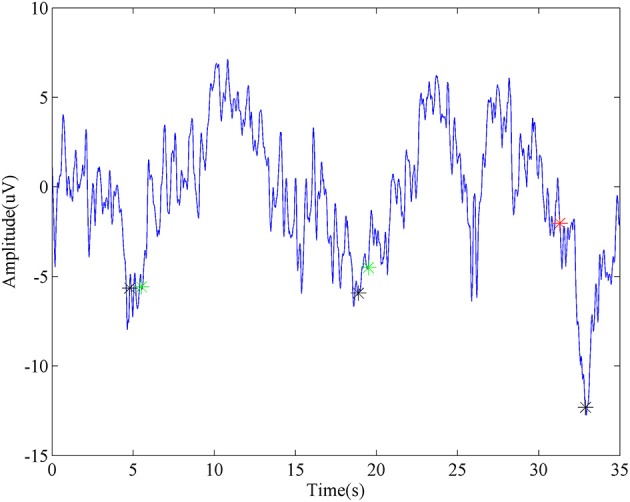
Representative detection of MRCP. The blue line is a segment of virtual Cz from ballistic task. Black stars stand for the task onsets. Green stars represent true detections, while the red star is a false detection.